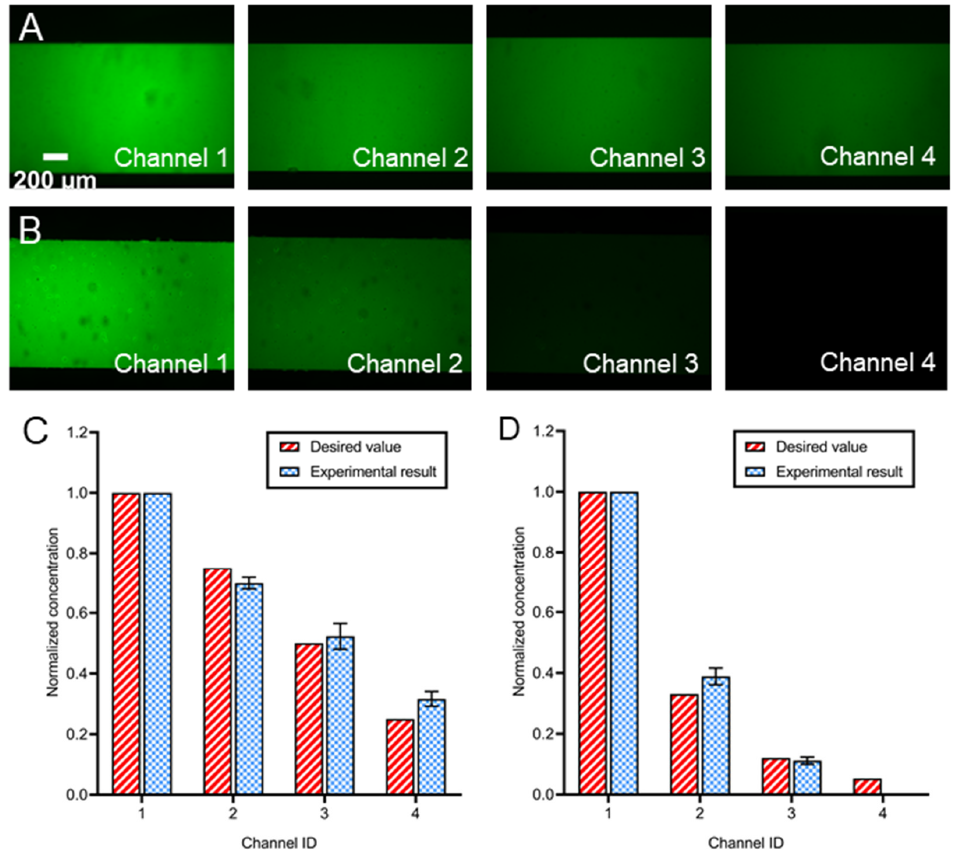
Figure 7. Generation of dynamic concentration using the microfluidic device. ( A ) Fluorescence images of the observation region with ( A ) linear and ( B ) nonlinear decline of concentration. The ( C ) linear or ( D ) nonlinear decline profile of the normalized concentration in four parallel channels. At least three different microchips were prepared and examined for each experimental condition.